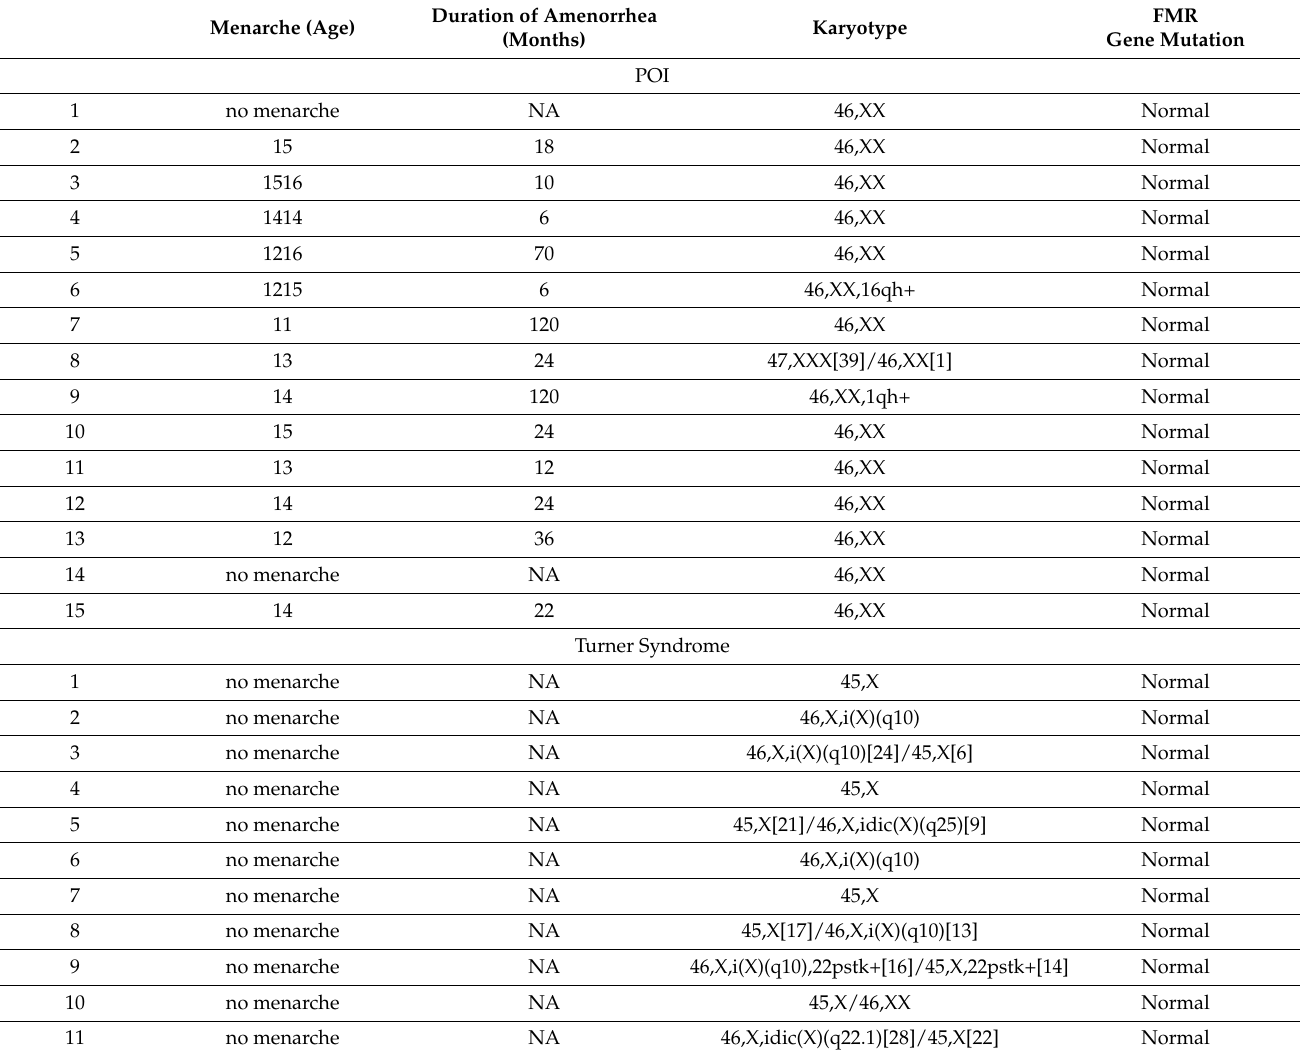
Table 4. Menstrual history of the patients and serum chromosomal analysis of both premature ovarian insufficiency and Turner syndrome groups in the validation